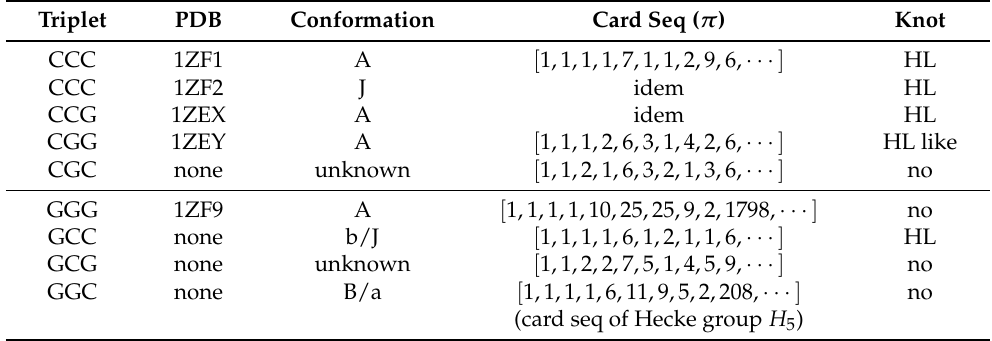
Table 6. Group analysis of the sequence d ( CCnnnN 6 N 7 N 8 GG ) , where N 6 , N 7 and N 8 are taken in the two nucleotides A,T [10]. Groups π 3 and π (cid:48) π (cid:48) is [ 1,7,50,867,15906,570528, · · · ] ; for π (cid:48)(cid:48) 3 [ 1,7,59, 1258,24787, · · · ]. Groups π (cid:48)(cid:48) π 2 , the fundamental group of the link L = A ∪ B described in Figure 3